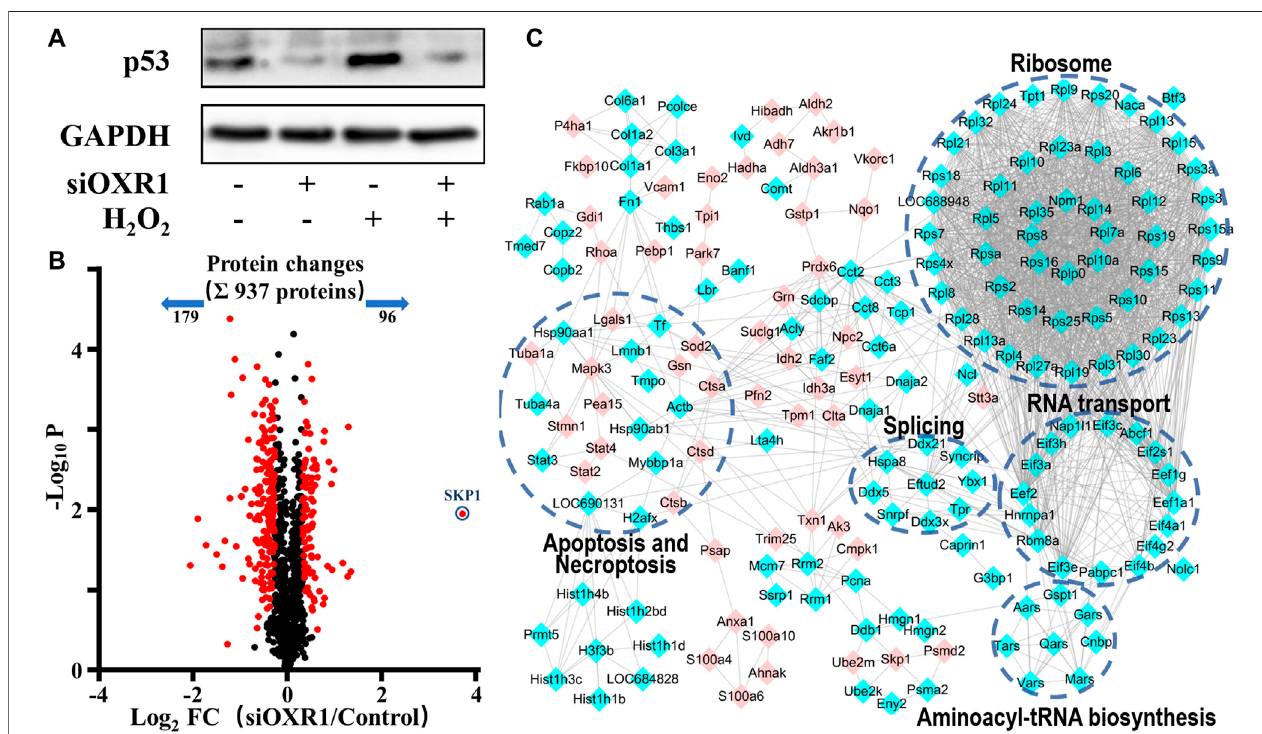
FIGURE 6 | The regulation mechanism of p53 by OXR1. (A) The OXR1 can regulate the protein expression of p53. (B) A volcano plot showed that 275 proteins changed signi fi cantly (FDR < 0.05, S0 of 0.5), among which SKP1 was observed to change most notably with a 12.9-fold upregulation. (C) The Gene Ontology- (GO-) based pathways enrichment of the altered proteins after OXR1